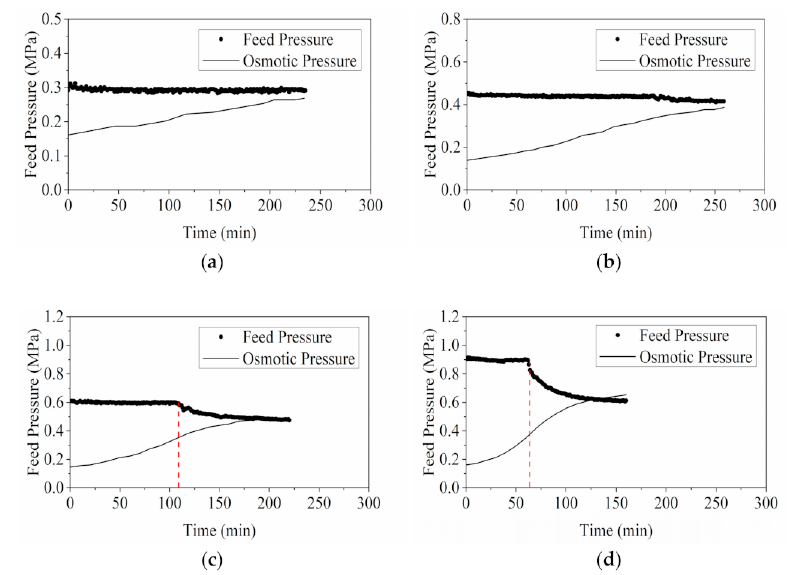
Figure 5. Profiles of operating feed pressure (MPa) and osmotic pressure (MPa) in RO experiments with different initial operating pressures: ( a ) 0.3 MPa; ( b ) 0.45 MPa; ( c ) 0.6 MPa; and ( d ) 0.9